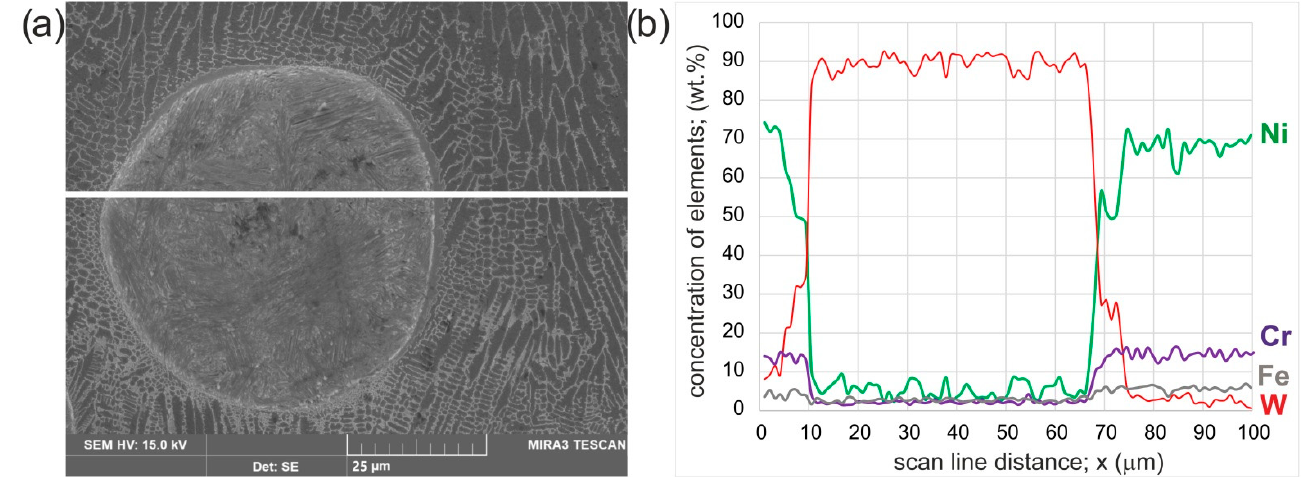
Figure 7. SE image and EDS mapping of tungsten, nickel, and chromium performed for a la- ser-alloyed layer produced with a laser beam power of 1.3 kW. Figure 8. SE image and results of linear X-ray microanalysis performed for a laser-alloyed layer produced with a laser beam power of 1.3 kW; the straight line across a single WC particle ( a ); the concentration of elements across this line ( b ).